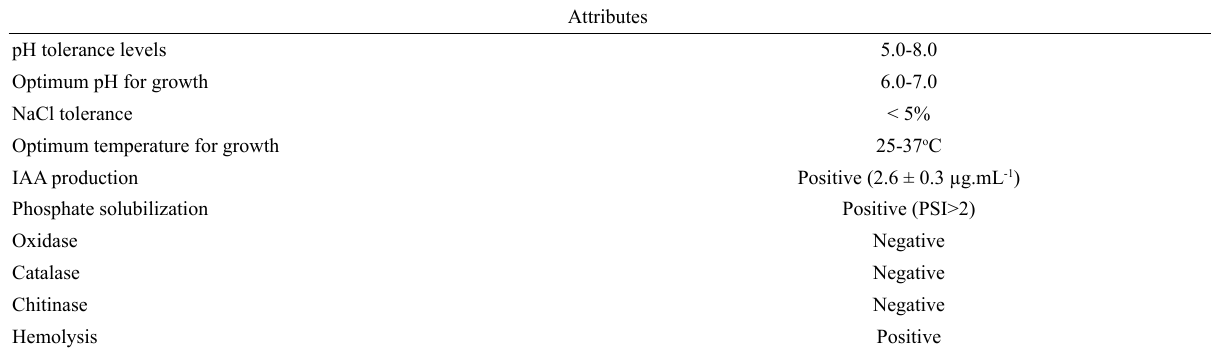
Table 2 – Biological and plant growth promotional properties of L. adecarboxylata strain Palotina.